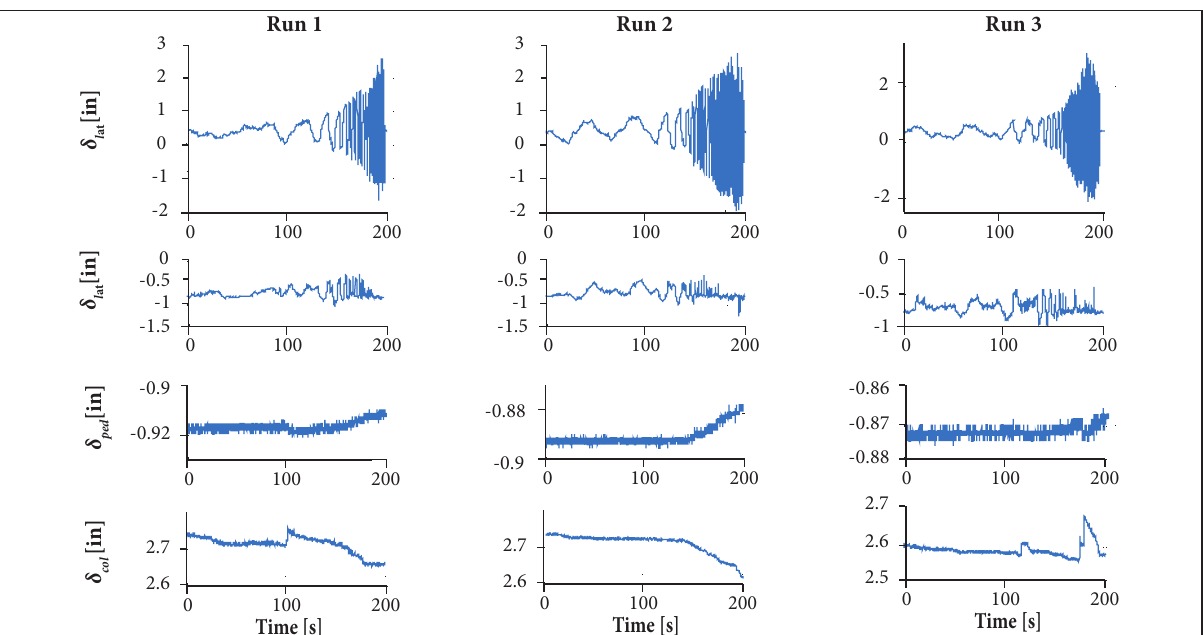
Figure 3. Longitudinal cyclic control inputs — level flight (80 KIAS).